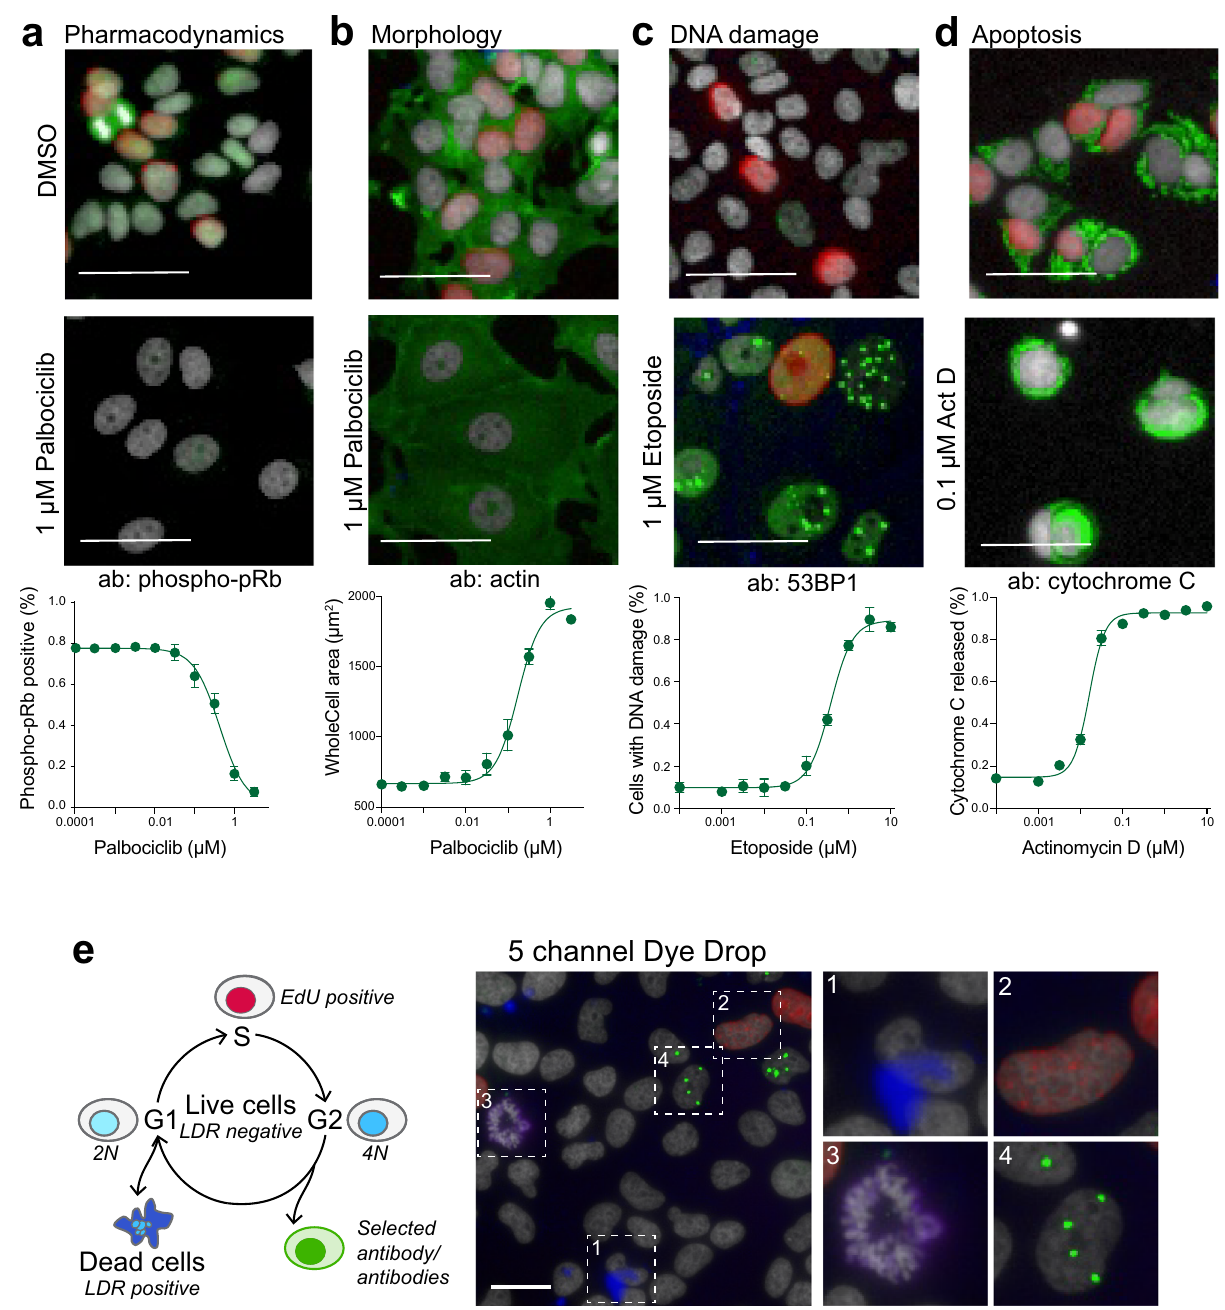
Fig. 2 | Customization of antibody incorporation in Dye Drop assays. a MCF7 cells stained with phospho-pRb and b actin untreated and after 72h in 1 µ M pal- bociclib; effects of increasing concentrations of palbociclib on the fraction of phospho-pRb positive MCF7 cells, or b on cell size as detected with actin staining after 72h. c MCF 10A cells stained with 53BP1 untreated and after 72h in 1 µ M etoposide; induction of DNAdamage by increasing concentrations of etoposidein MCF10Acells as detected with 53BP1staining after72h. d MCF7cellsstained with cytochromeCuntreatedandafter72hin0.1 µ MactinomycinD;effectofincreasing